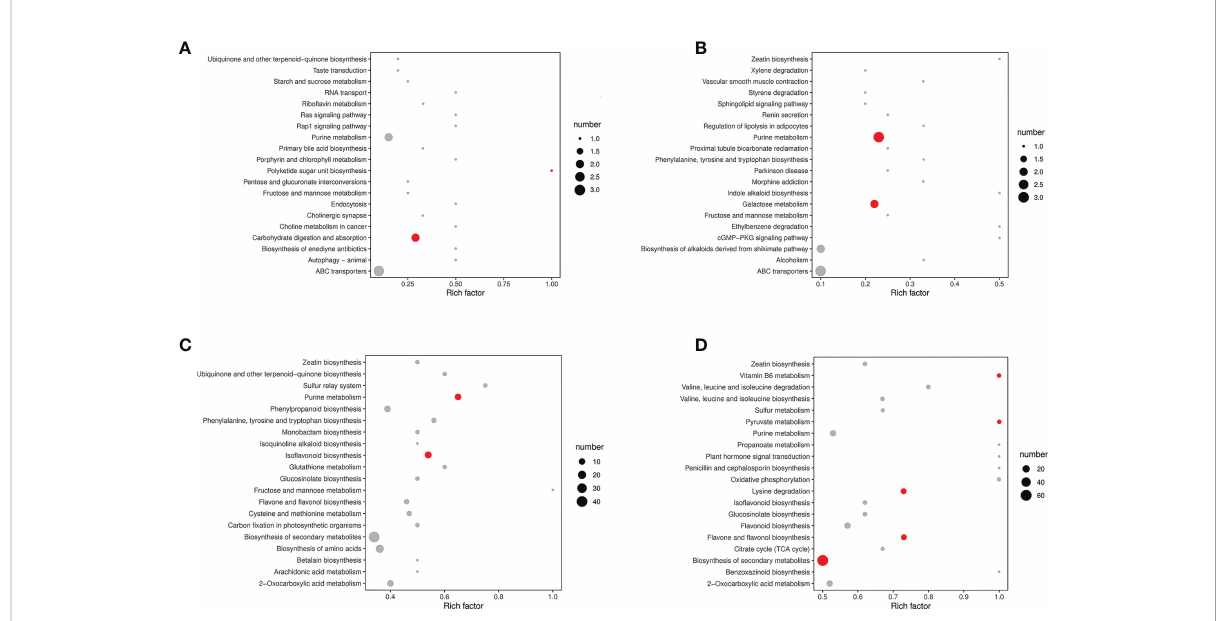
FIGURE 5 The top 20 pathways of signi fi cant of the upregulated and down-regulated differential metabolites on KEGG. (A) MP-S vs. IP-S comparison; (B) MS-S vs. IS-S comparison; (C) MP-R vs. IP-R comparison; (D) MS-R vs. IS-R comparison. Red indicated that the pathway was signi fi cantly enriched (P < 0.05), and gray indicated that the pathway was not signi fi cantly enriched. Panel A and B are plotted based on the mean of six replicates, and panel (C, D) were plotted based on the mean of three replicates.